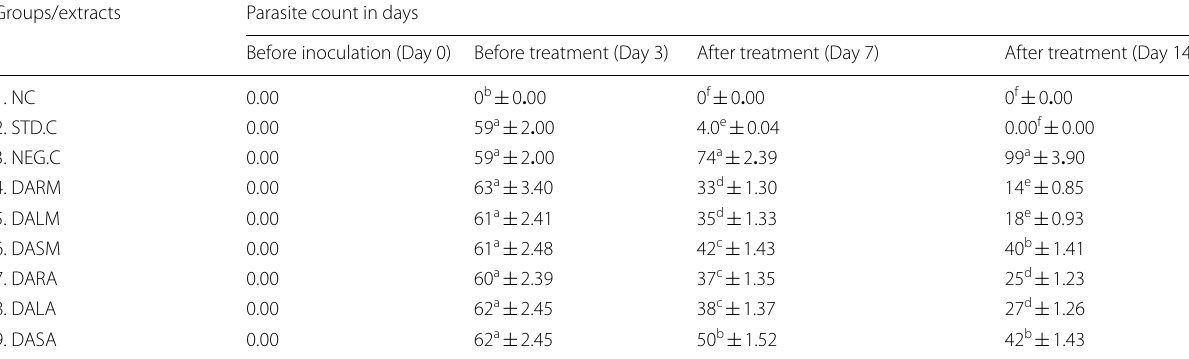
Values are average parasite count NC Normal control, STD.C = arborescens stem methanol, DARA